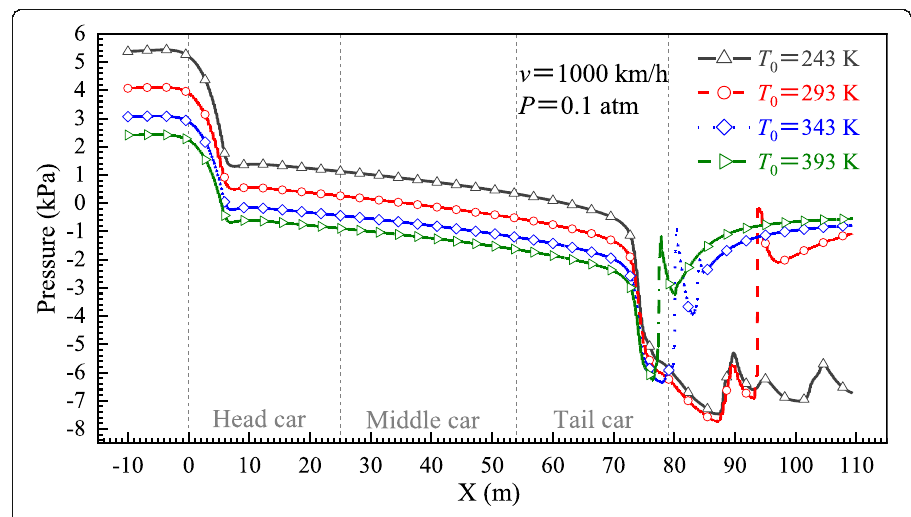
Fig. 18 Pressure along the top of the tube wall at different T 0 : x -coordinate ranges from − 10 m to 110 m